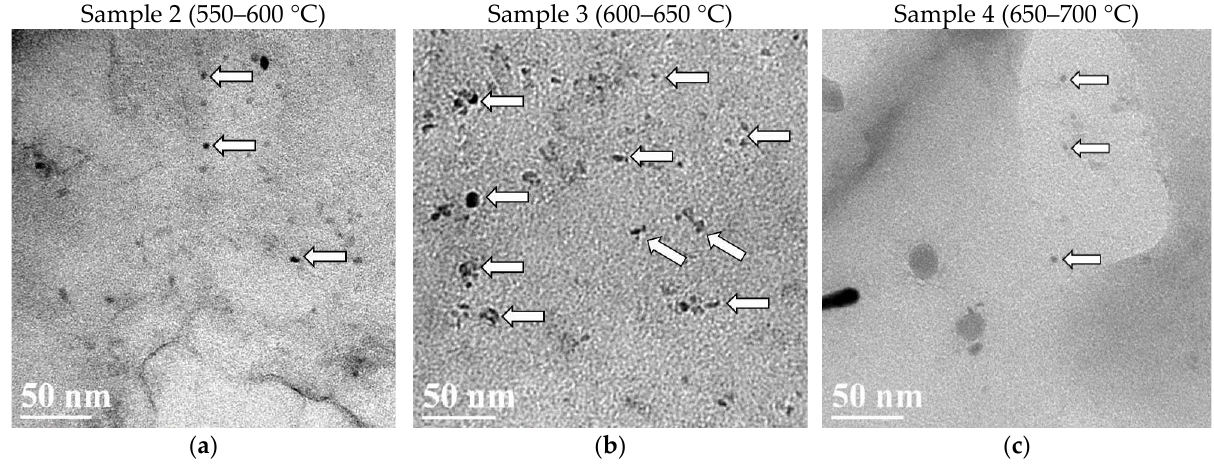
Figure 12. Effect of coiling temperature on TiC precipitation (precipitates are indicated in arrows): ( a ) Sample 2 (Tcoiling 550–600 °C), ( b ) Sample 3 (Tcoiling 600–650 °C), ( c ) Sample 4 (Tcoiling 650–700 °C).